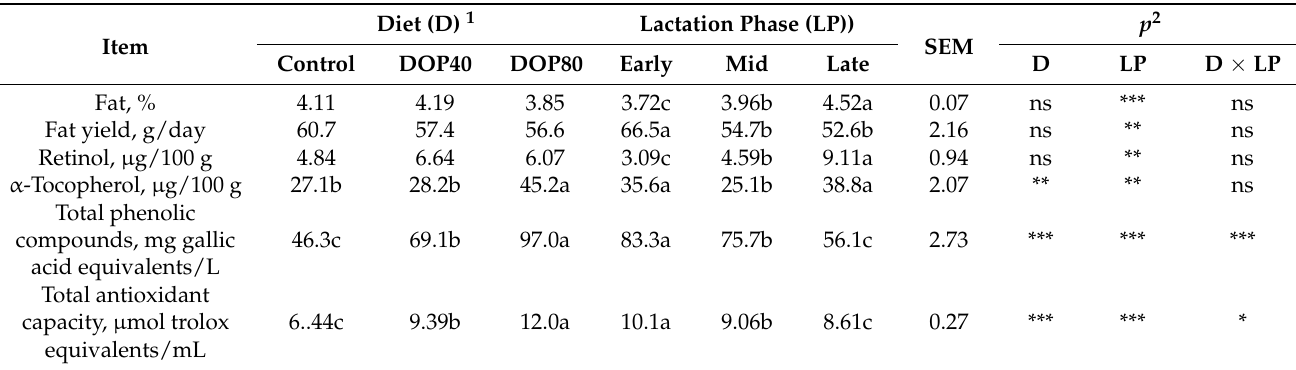
Table 2. Effects of experimental diets 1 and lactation phase on resultant milk’s fat-soluble vitamins, phenolic compounds, and antioxidant